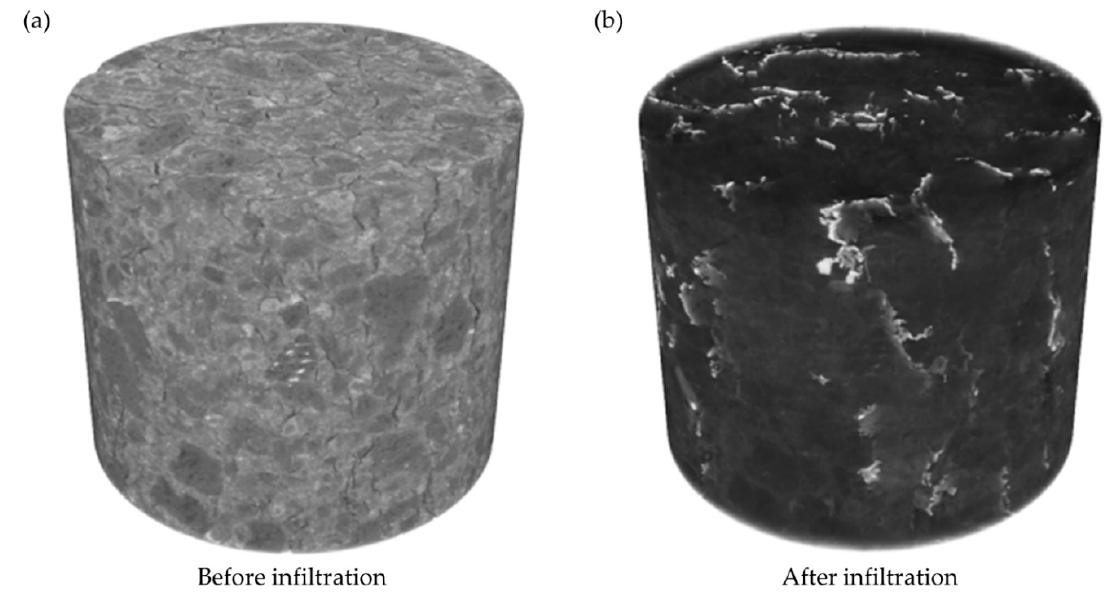
Figure 7. Three-dimensional visualization of samples: ( a ) before and ( b ) after the HMP test.